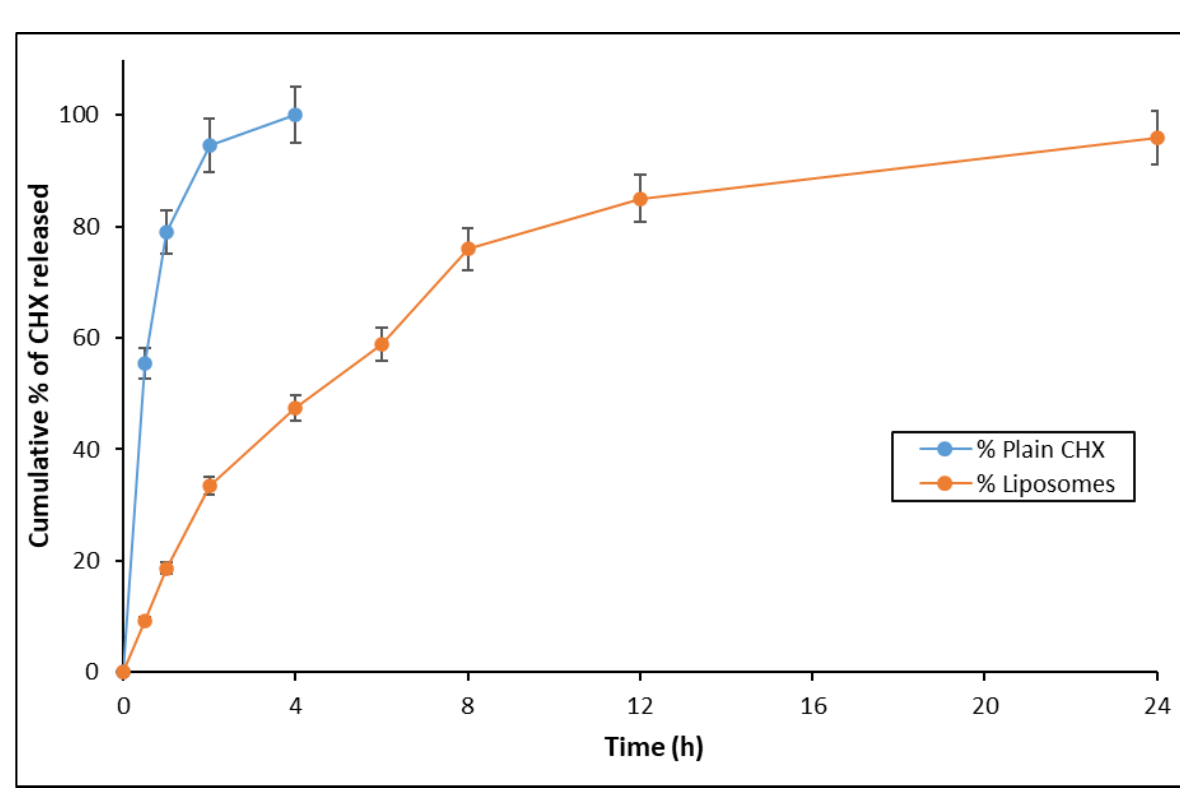
Figure 3. In vitro drug release profile of CHX in its plain form and liposomal form. Table 2. Depth of penetration of plain CHX solution and liposomal CHX in dentinal